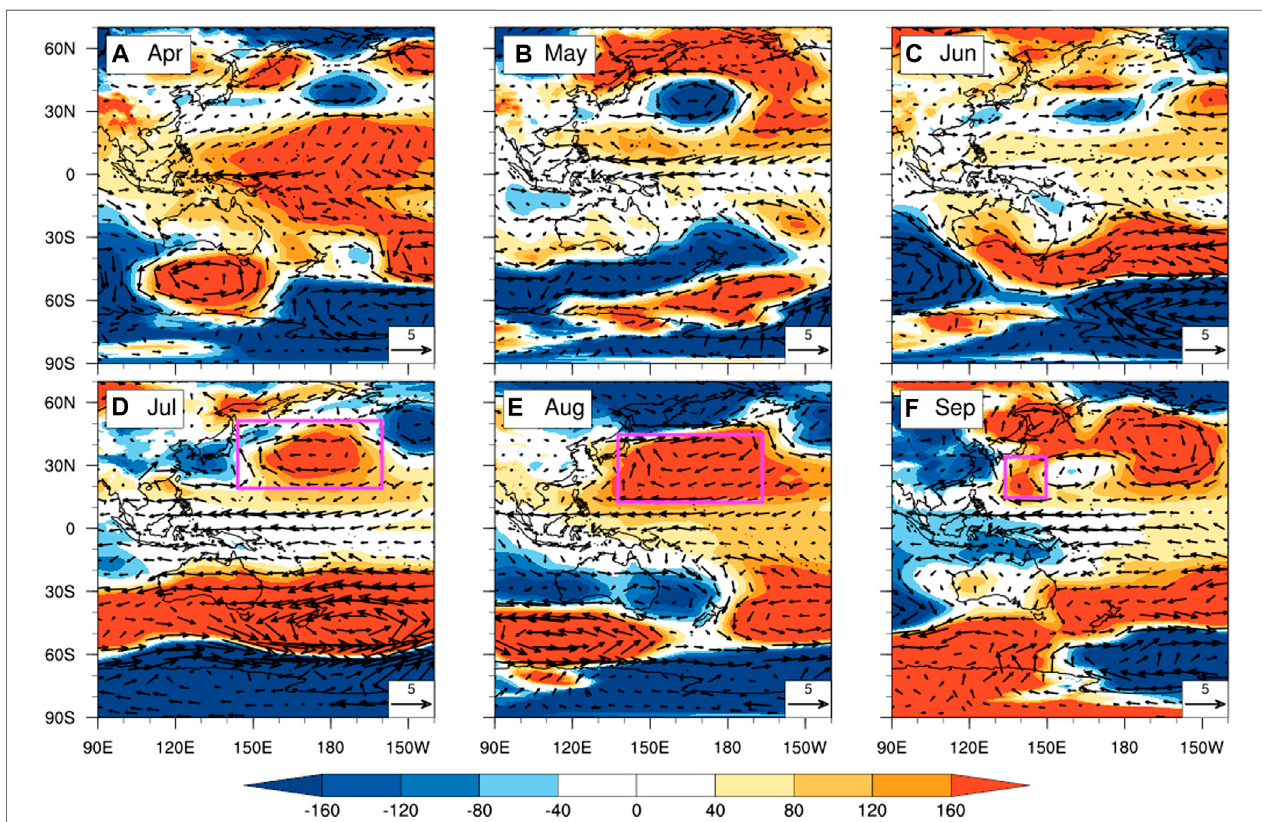
FIGURE 8 | Composite differences of (A) April, (B) May, (C) June, (D) July, (E) August, and (F) September mean SLP (shading; unit: Pa) and 850-hPa wind anomalies (vector; unit: m s − 1 ) between the extreme high and low years of SLP TCP,4 . Pink rectangles in (D – F) specify the anomalous eastward shift of subtropical high that highly associates with the positive phase of